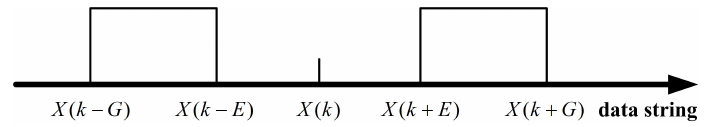
Figure 1. The schematic diagram of the TPSW